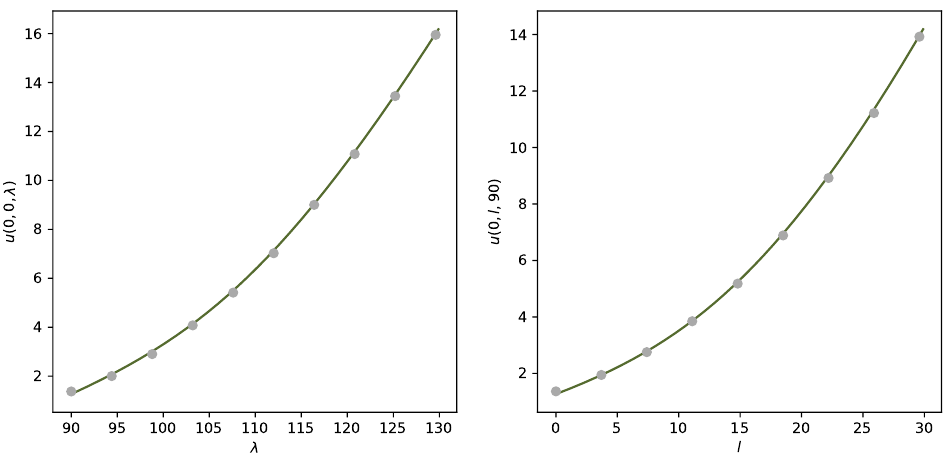
Figure 1. Solution U 0 ( l , λ ) for l = 0, λ ∈ [ 90,130 ] ( left ) and l ∈ [ 0,30 ] , λ = 90 ( right ) computed with the DNN-algorithm ( green line ) and reference points computed with Monte Carlo ( grey dots